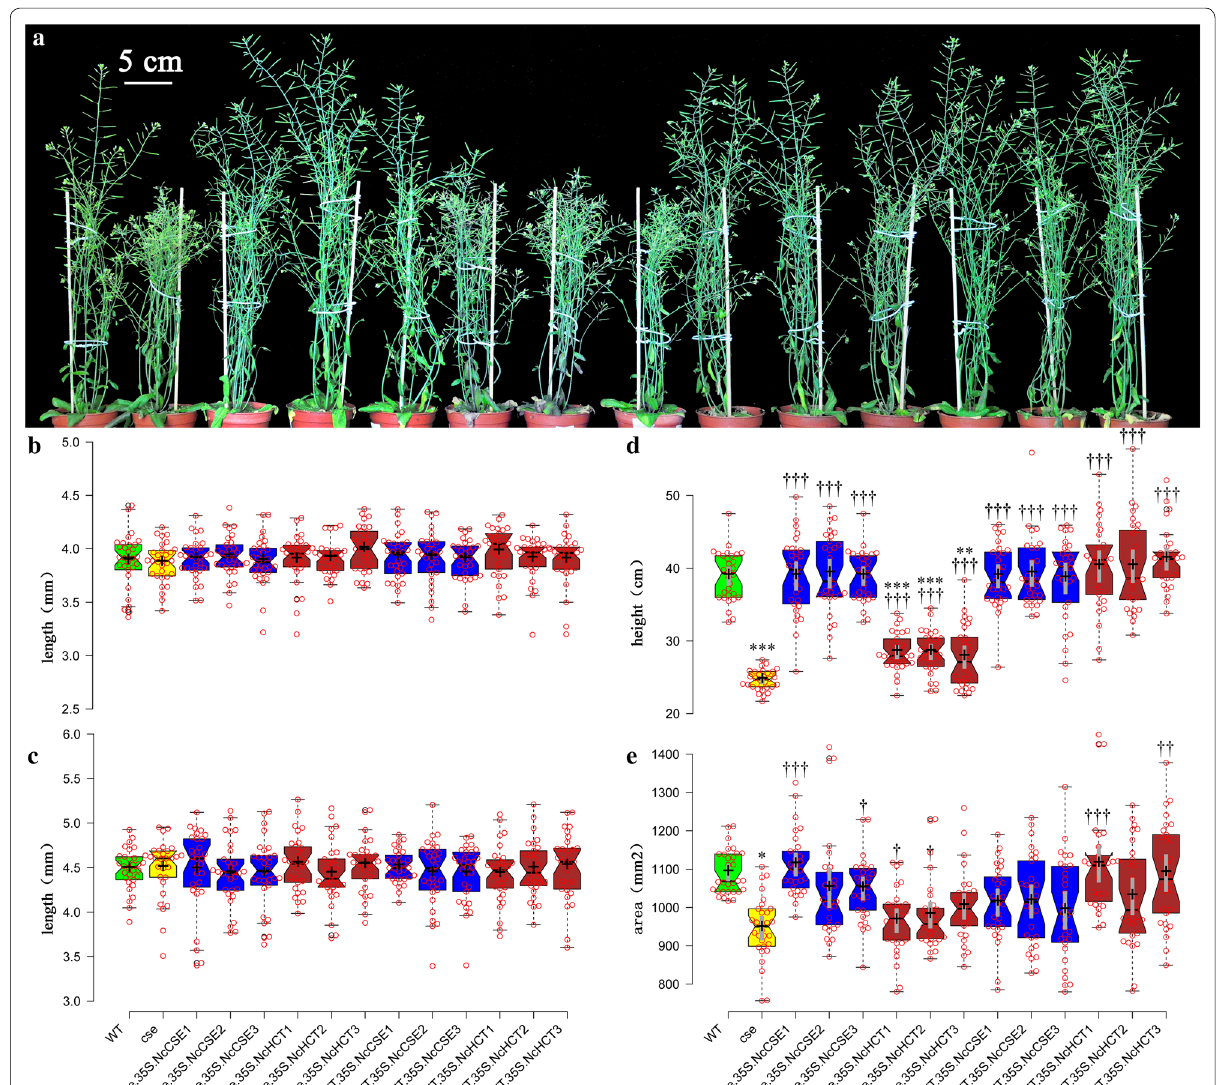
Fig. 3 Phenotype statistics for the 14 lines, Thirty plants were measured for each line, a representative plants of each line; b hypocotyl lengths at day 7 after planting; c hypocotyl lengths at day 14 after planting; d plant height at day 50 after planting; e main stem diameter at day 50 after